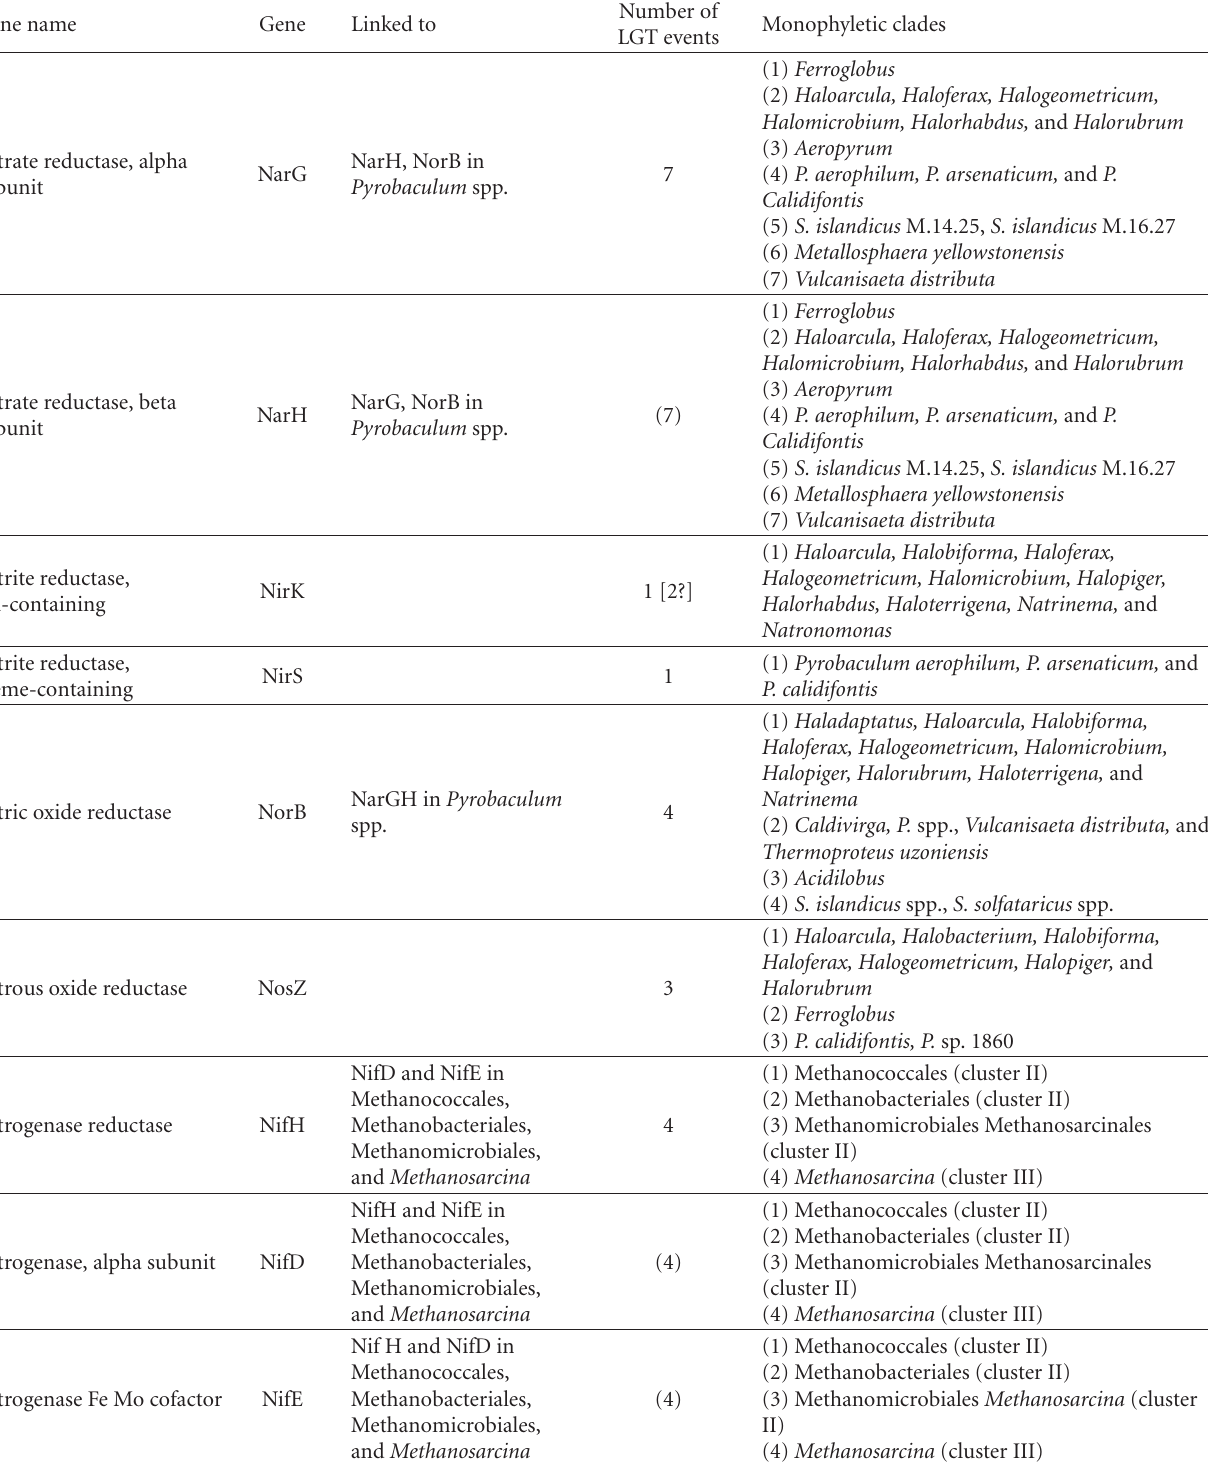
Table 3: Nitrogen